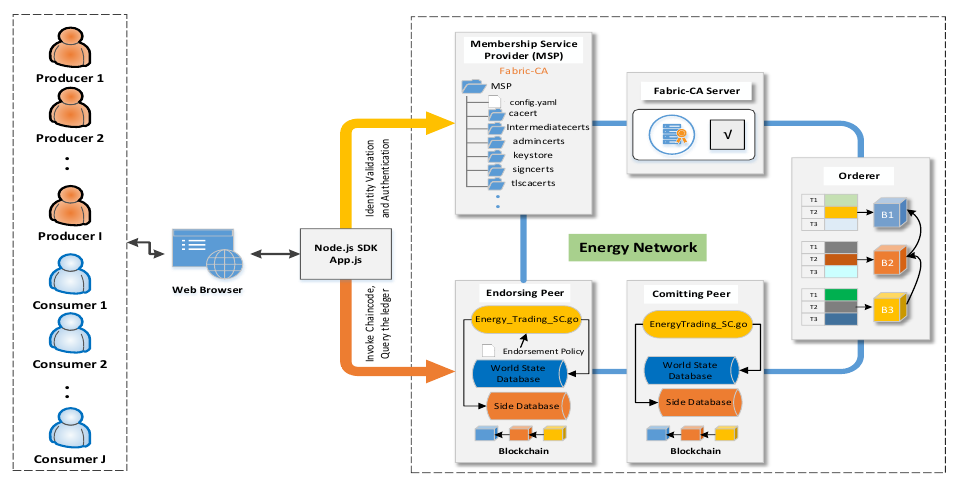
Figure 2. The implementation of SPETS using Hyperledger